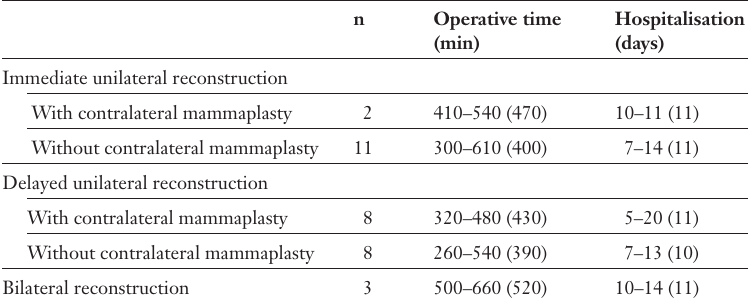
Surgery and hospitalisation (n = 32 patients), range (median). The values for operative time are rounded to 2 significant